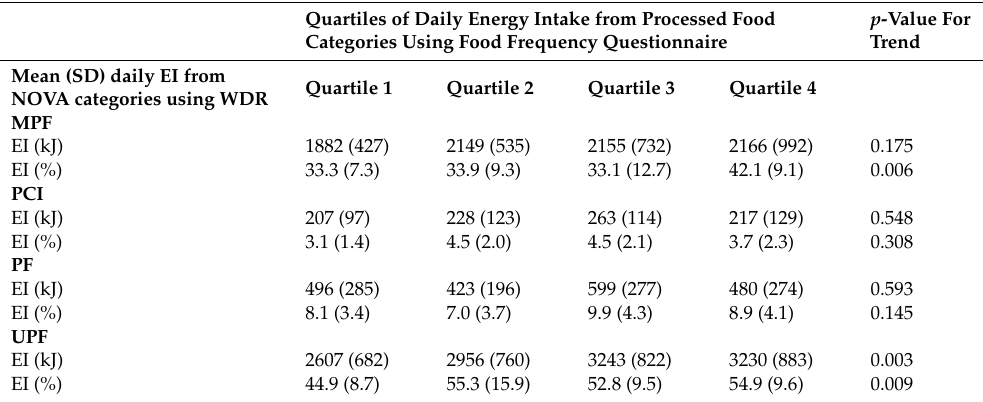
p -Value For Trend